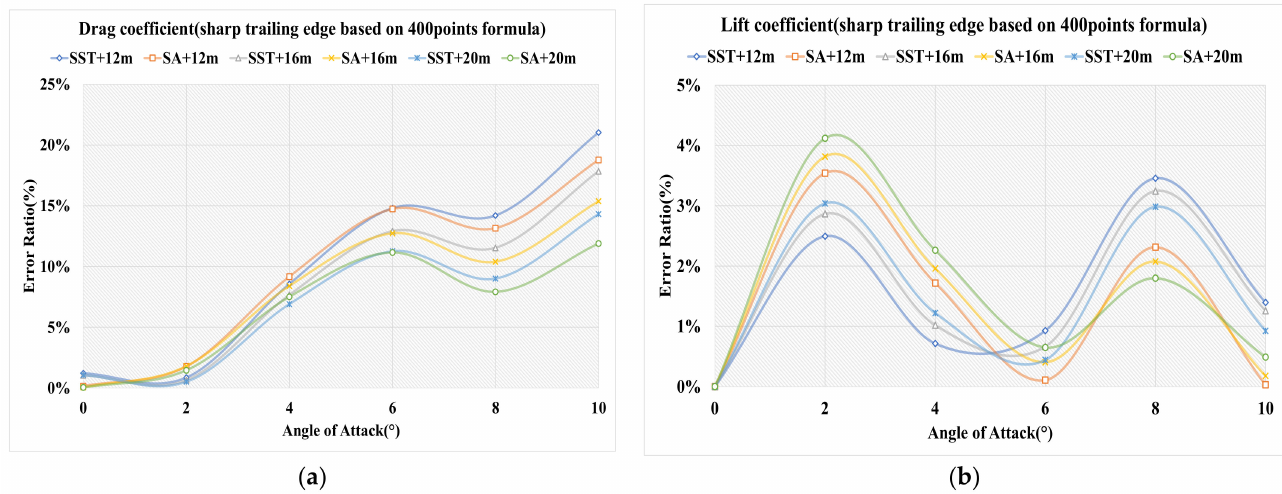
Figure 11. ( a ) Drag coefficient of sharp trailing edge based on 400 points formula; ( b ) lift coefficient of sharp trailing edge based on 400 points